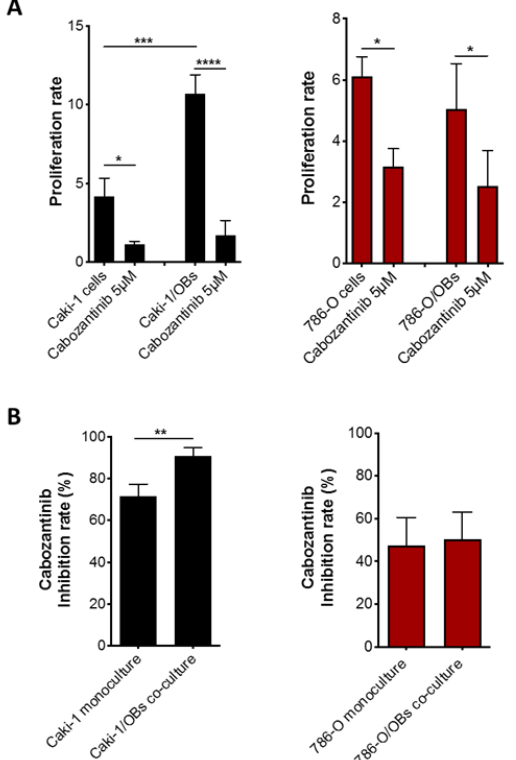
Figure 4. Antitumor effect of cabozantinib in the RCC bone microenvironment. Proliferation ( A ) and inhibition rates ( B ) of Caki-1 GFP+ (left panels) and 786-O GFP+ (right panels) cells after a cabozantinib treatment (5 μM) in a monoculture or cocultured with OBs. Data are expressed as the mean ± SD; * p ≤ 0.05, ** p ˂ 0.01, *** p ˂ 0.001 and **** p ˂ 0.0001.